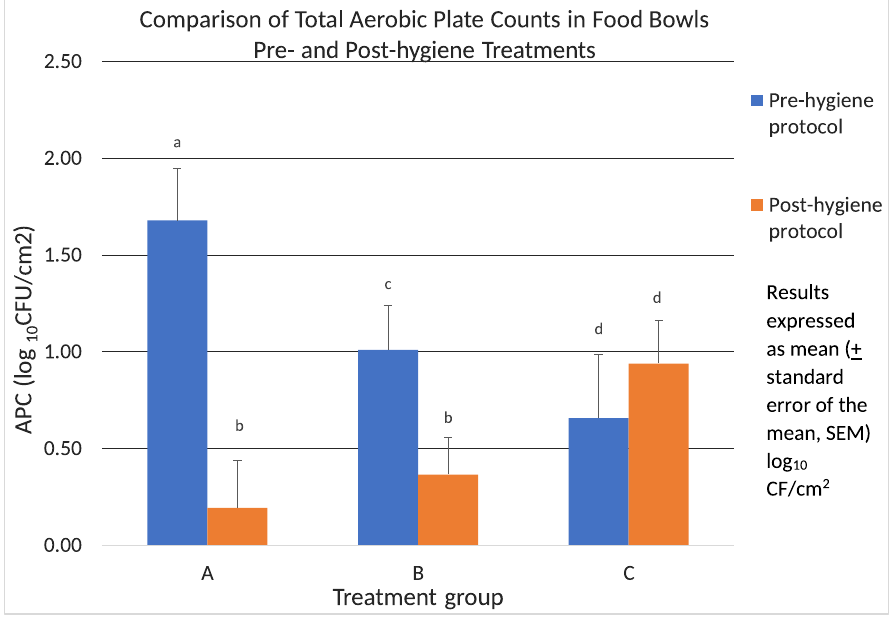
Fig 3. Comparison of the total aerobic plate counts in studied dog bowls pre- and post- hygiene treatment. APC on a basis of colony forming units (CFUs) per cm 2 of studied bowls pre- and post-hygiene treatment. Superscripts that differ within a group indicated significant differences (p < 0.05). Similar superscripts across groups indicate no significant difference (p � 0.05).